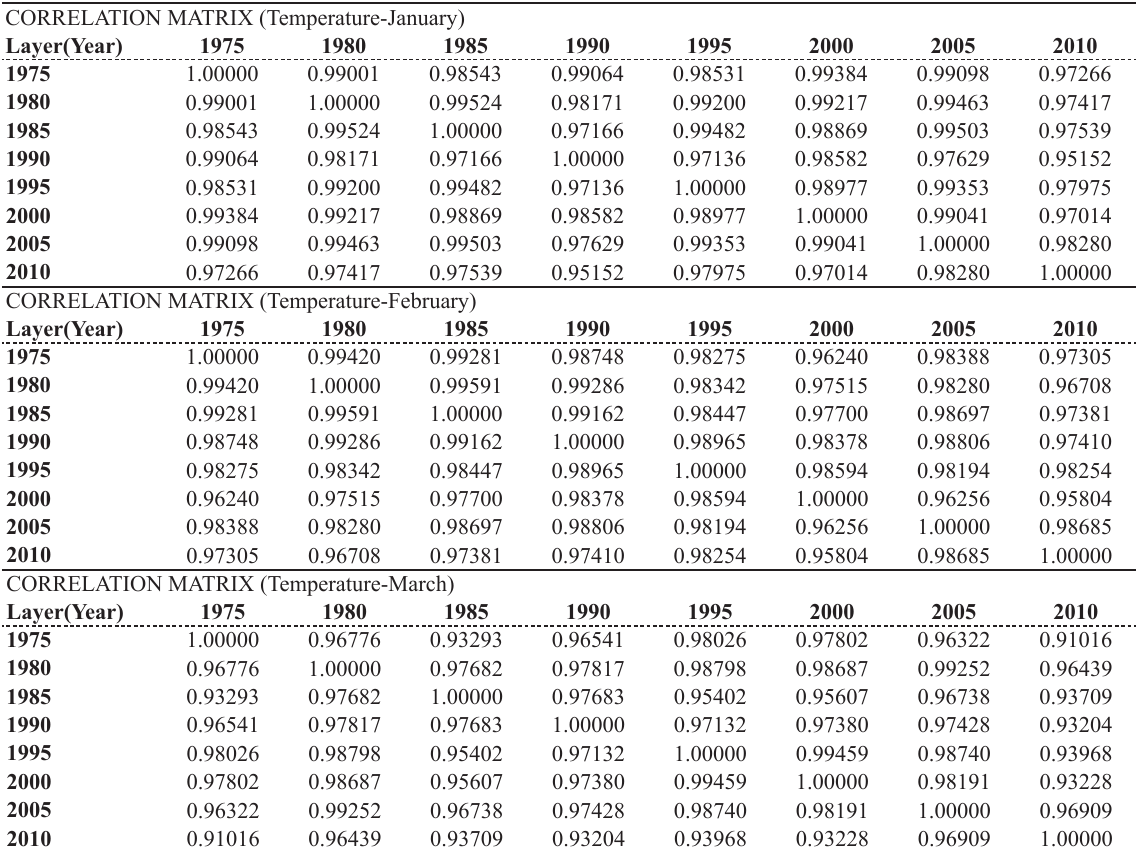
correlation matrix for temperature